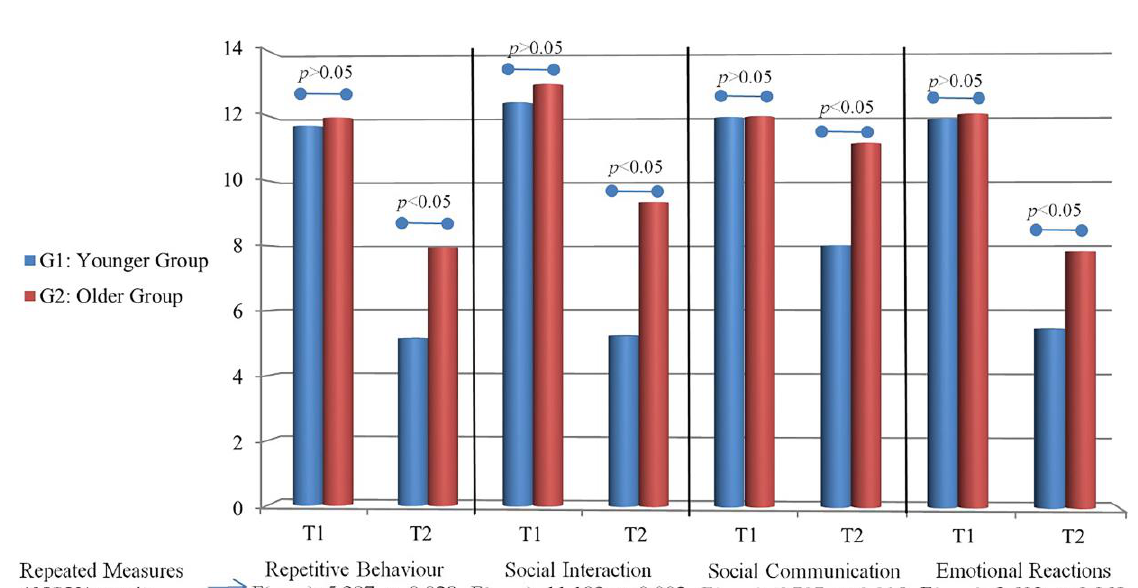
Figure 3. Average scores on each GARS III subscale for G1 and G2 at two time points, and repeated measures ANOVA results.